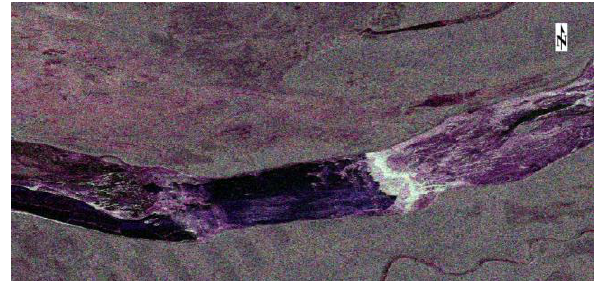
Figure 2. Vermilion Chutes on 08.12.2013. RADARSAT-2 band combination RGB HH HV VV (© MacDonald, Dettwiler